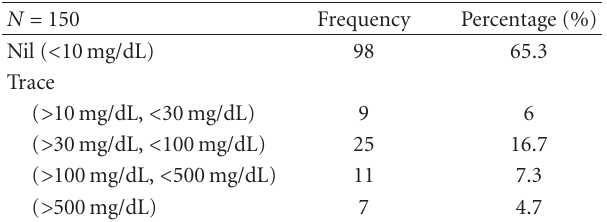
Table 4: Pattern of proteinuria in the